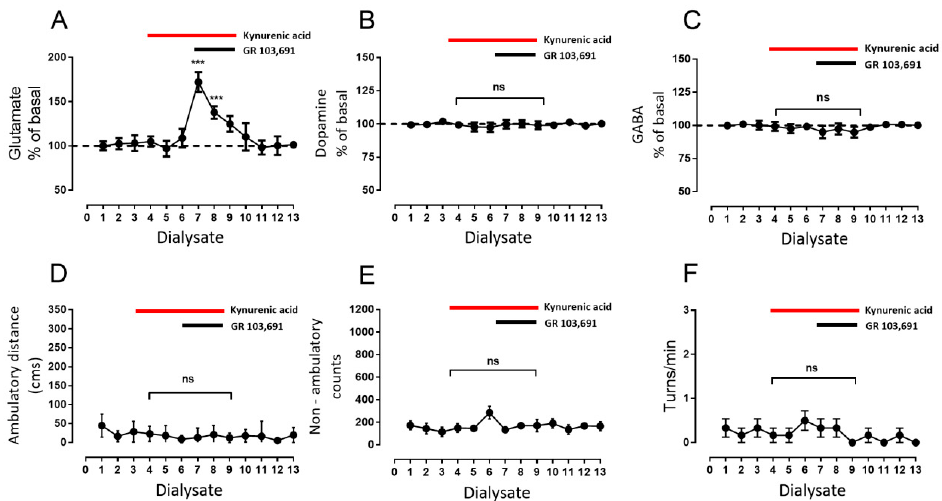
Figure 4. Blockade of intra-nigral NMDA receptor (NMDAR) prevents increments of dopamine, GABA, and behavioral e ff ects, but not of glutamate, induced by D3R blockade. ( A – C) show the e ff ect of intra-nigral NMDAR blockade with kynurenic acid (500 µM, from dialysate three to eight) on the interstitial concentration of glutamate, dopamine, and GABA, alone or in co-perfusion, of D3R antagonist GR 103,691 (100 nM, from dialysate six to eight). ( D – F) present the behavioral e ff ects of co-superfusion of the antagonists in ambulatory distance, non-ambulatory counts, and turns / min, respectively. *** p < 0.001 with respect to dialysate six; ns, non-significant di ff erences between dialysates. Two-way ANOVA followed by Tukey, n = 6